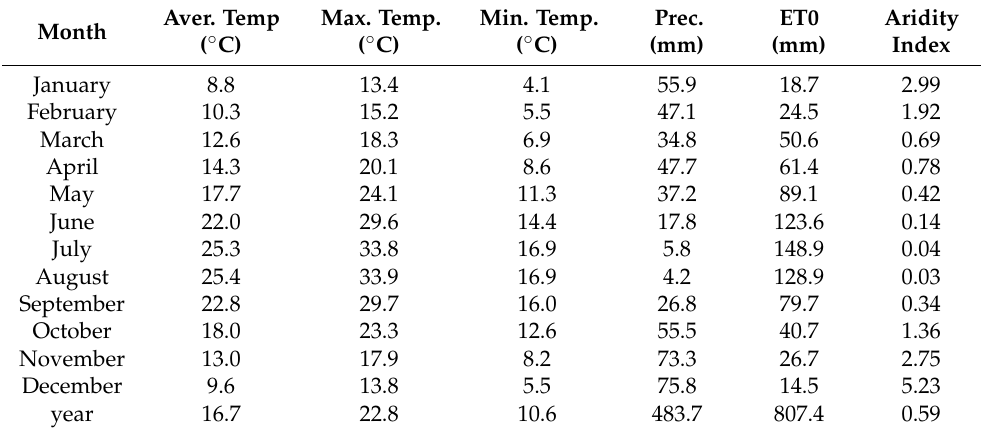
Table 2. Climate normal 1981/2010 (data registered in the study area meteorological station).